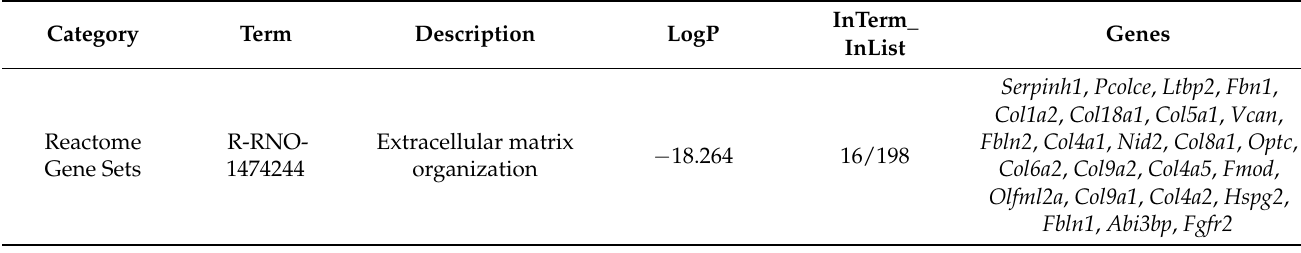
Table 3. Top Reactome pathways significantly enriched in DEGs related to anti-apoptosis in NK-5962-treated retinas (Metascape).